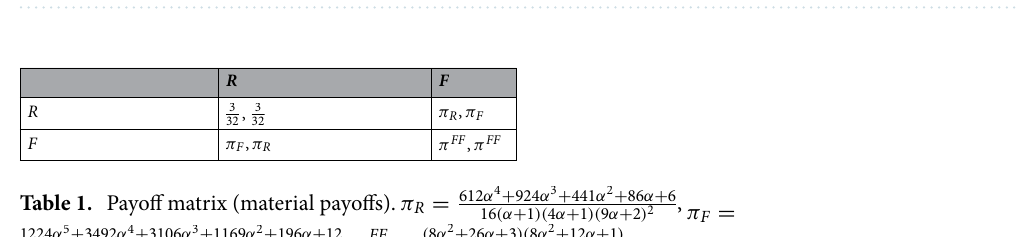
Figure 2. Numerical observation of final fraction of fair players ( p final ) and the average fitness of the population ( ¯ π final ) from the replicator dynamics of incomplete case. ( A ) For each pair of parameter values p 0 and α , the final fractions of fair players in equilibrium are presented as color scale. The black region means only rational players can survive in final state while both types of players can coexist in the yellow region. ( B ) For each pair of parameter values p 0 and α , the average fitness of the population ( ¯ π final ) in equlibrium are presented as color scale, too. The yellow region denotes a higher average fitness compared to the brown region. It indicates that evolution does not favor the population distribution with the highest average fitness, when players interact globally.